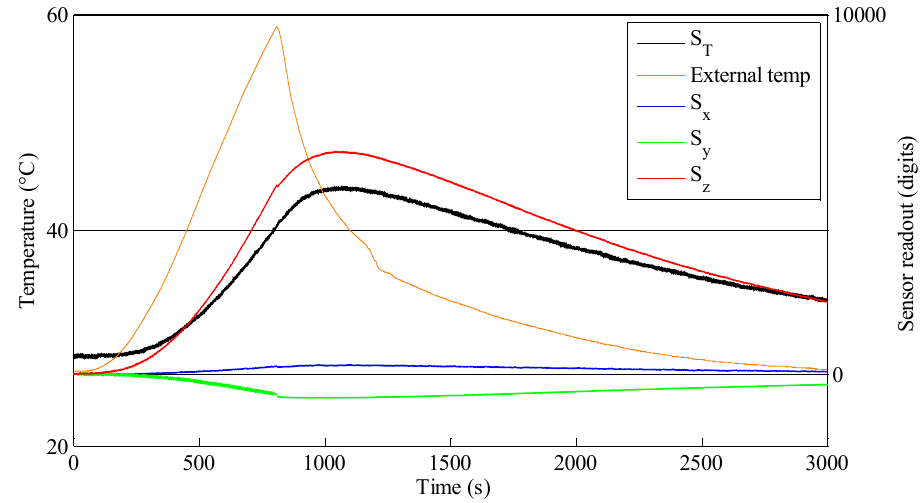
Figure 4. The effect of temperature changes on the sensor measurement.